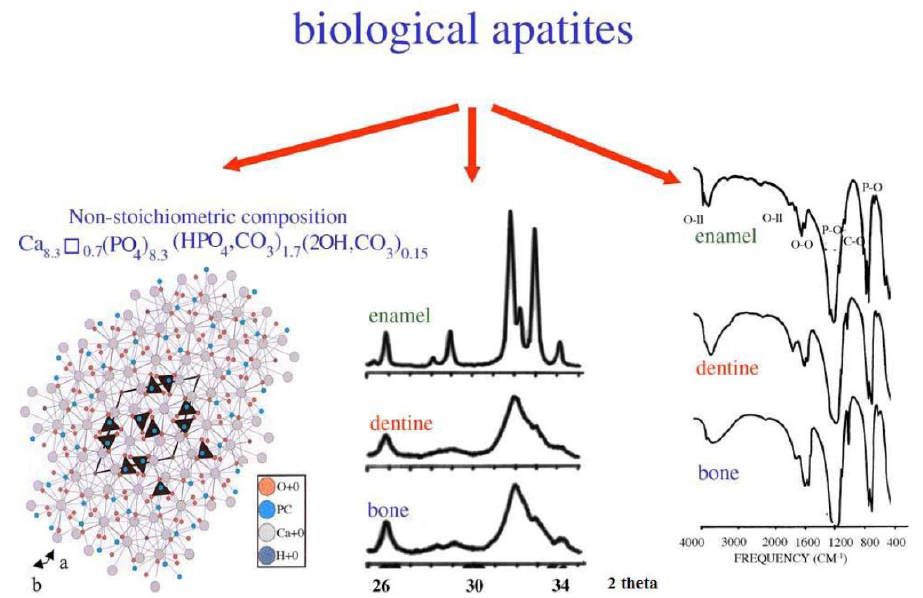
Figure 1. Crystal structure of biological apatites. Powder X-ray diffraction patterns and infrared spectra of enamel, dentine, and bone [11] .